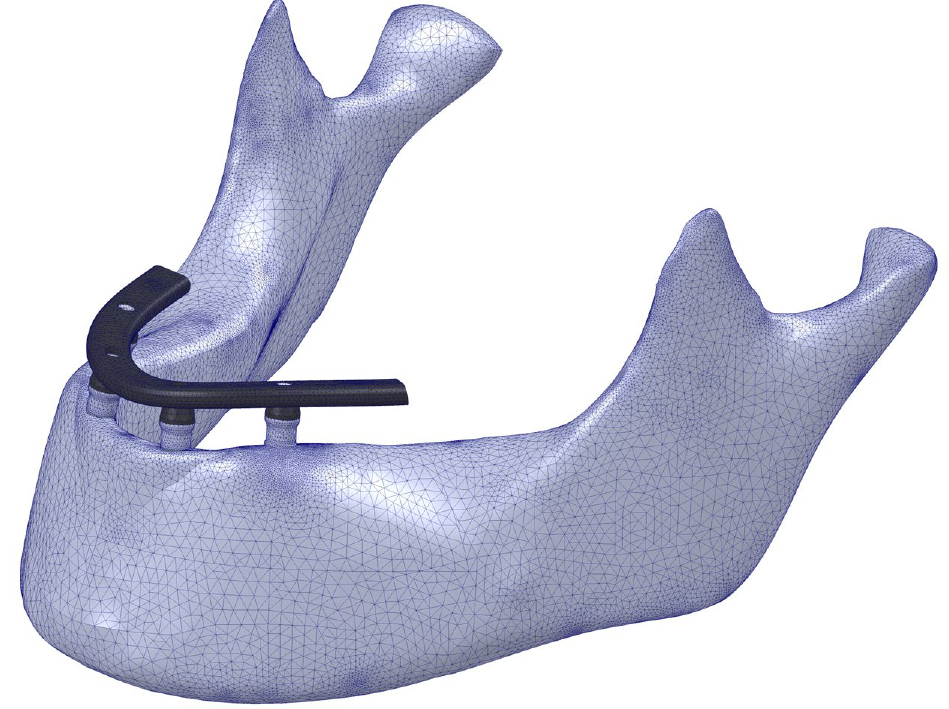
Figure 3. FE model mesh of case 4-A, the mesh refinement area in the ROI can be observed. All materials were modeled as homogeneous, isotropic, and linear. The material properties of each of the components are described in Table 2. The mesh between the implant interface and the bone tissue was performed by means of a rigid bond contact with compatible mesh (the entities in contact were meshed in such a way that there was a node- to-node correspondence between the meshes of each entity), simulating a stage of complete bone-to-implant osseointegration. For the remaining connections among components, a rigid bonding contact was also used, although in this case, the mesh was not compatible between the contact surfaces. All degrees of freedom were restricted at the articular face of the condyles and a load of 200 N angled at 30 ◦ was applied at a distance of 5 mm from the distal end of the prosthesis (Figure 4)